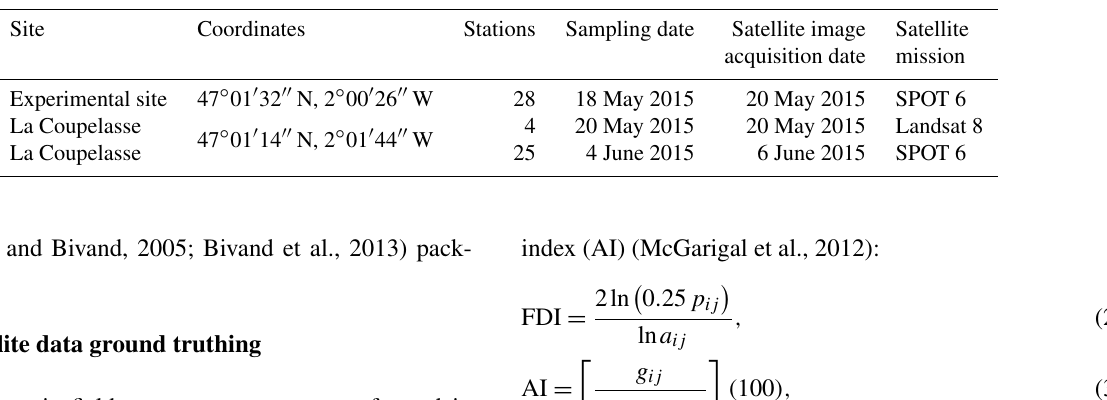
Table 2. Field measurements performed for satellite